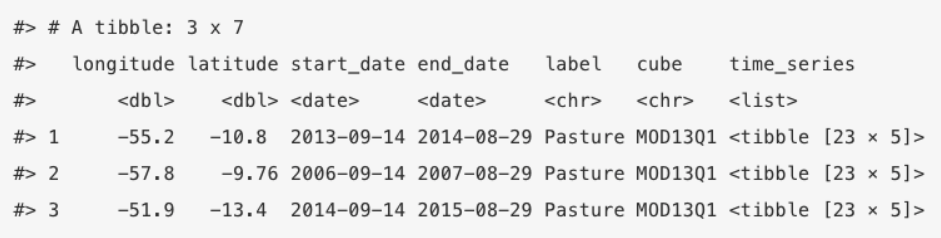
Figure 4. Data structure for time series (source: